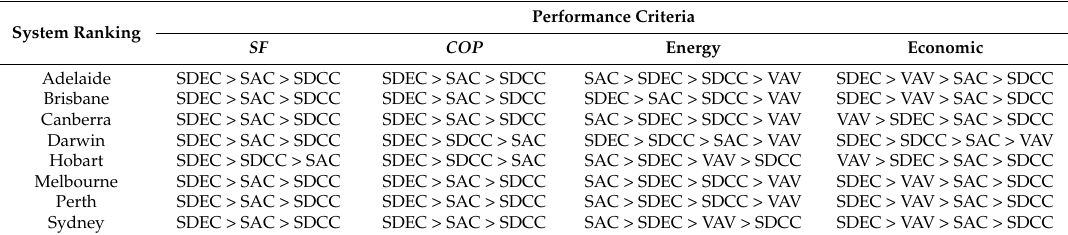
Table 16. Simple system ranking for each